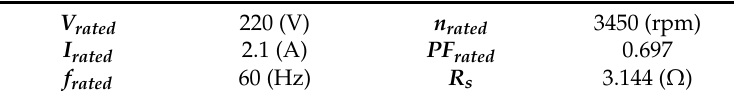
Table 2. Rated data of the IM used in the experimental tests.